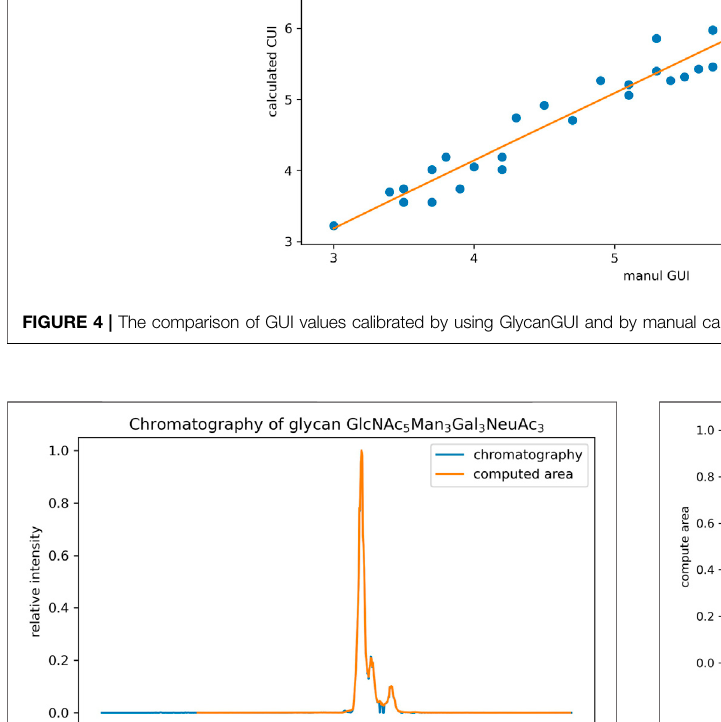
FIGURE 6 | The calibration and quanti fi cation of glycan isomers distinguished by different peaks in the extracted ion chromatogram of the precursor ions with the same m/z.